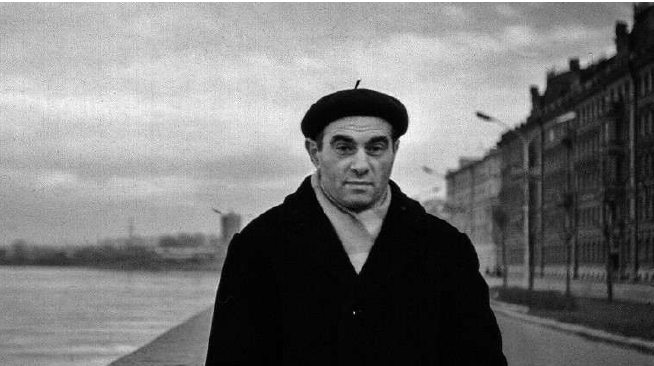
Figure 3. Early 1970s. Embankment of the Neva river in Leningrad (now St. Petersburg). From Gliner family archive; courtesy of Arkady and Bella